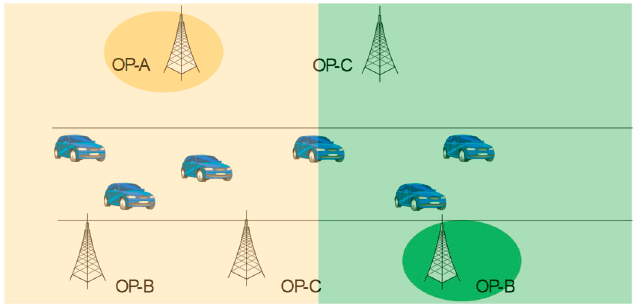
Figure 10. Split of a highway.